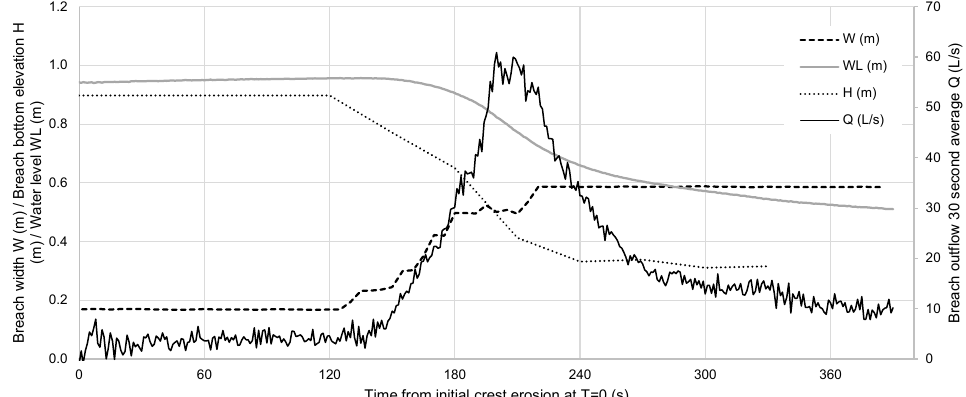
Figure 14. Breach width (W) and breach bottom elevation (H) for model U4 (central core) plotted against breach outflow (Q) and upstream water level (WL).